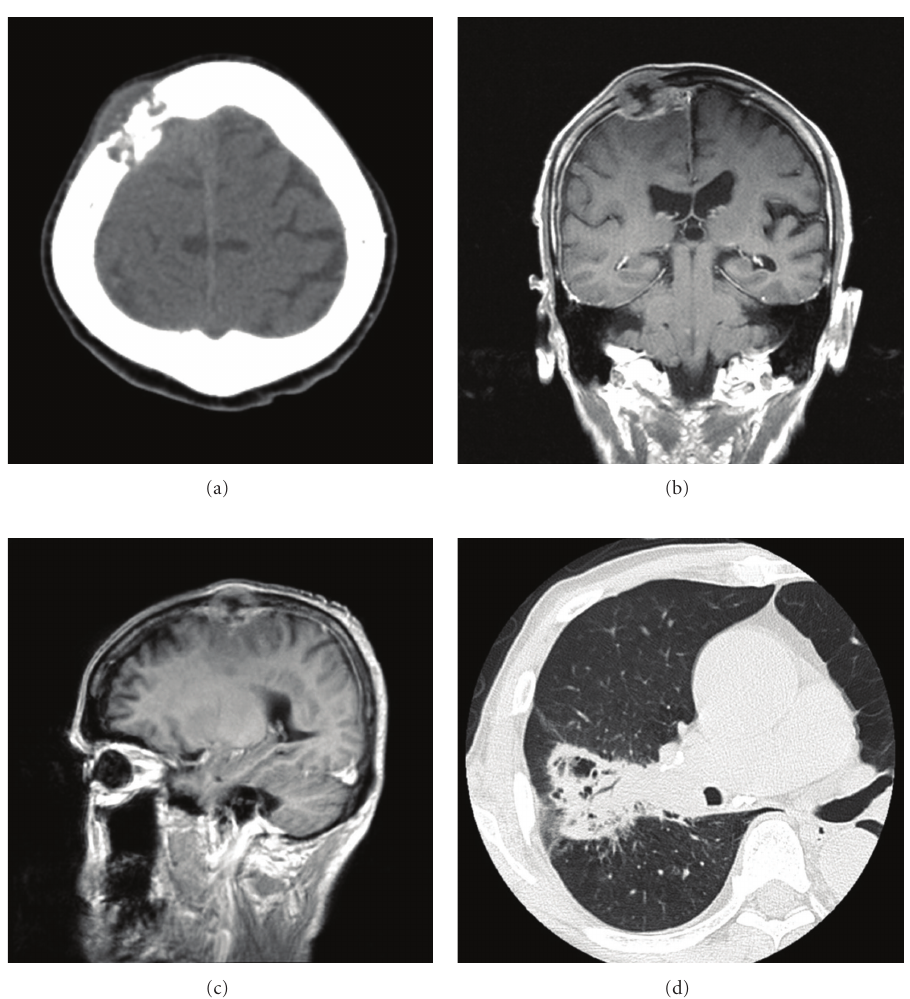
Figure 1: Computed tomographic scan of the brain shows an osteolytic tumor in the right frontal region (a). Coronal (b) and sagittal (c) T1-weighted magnetic resonance images with gadolinium-diethylenetriaminepenta-acetic acid revealing a heterogeneously enhanced tumor in the right frontal region with perifocal edema. The tumor was attached to the wall of the superior sagittal sinus and dura. Computed tomographic scan of the chest reveals an endobronchial growth in the hilum of the right upper lobe (d).